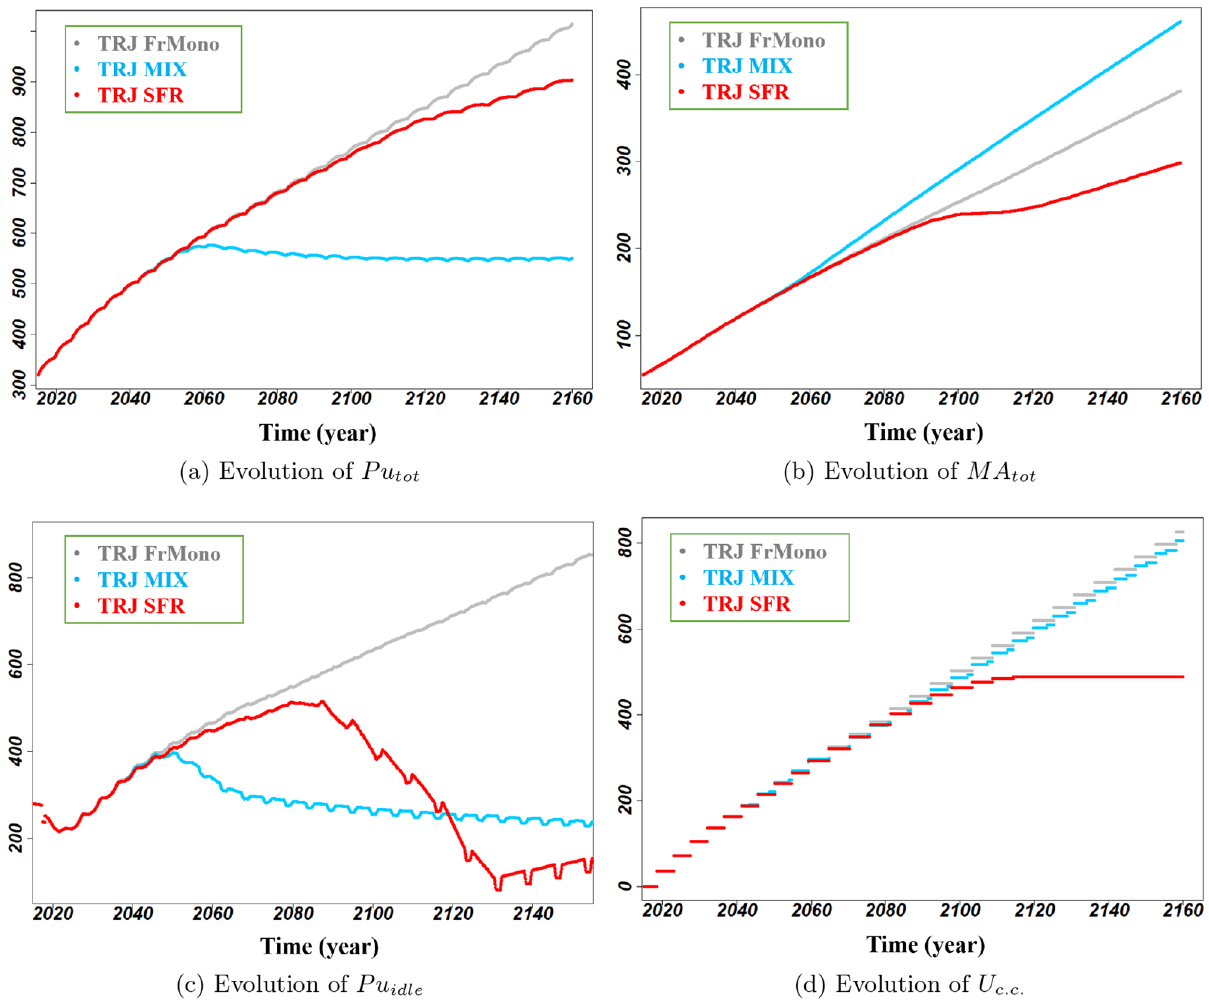
Fig. 6. Evolution of Pu tot , MA tot , Pu idle (in t) and U c.c. (in kt) in the prior trajectories TRJ FrMono , TRJ MIX and TRJ SFR